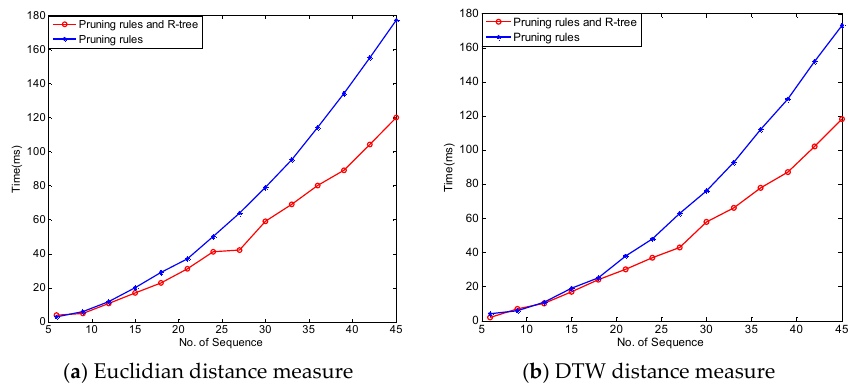
Figure 11. Effect of pruning levels on the performance of distance matrix calculation algorithms.